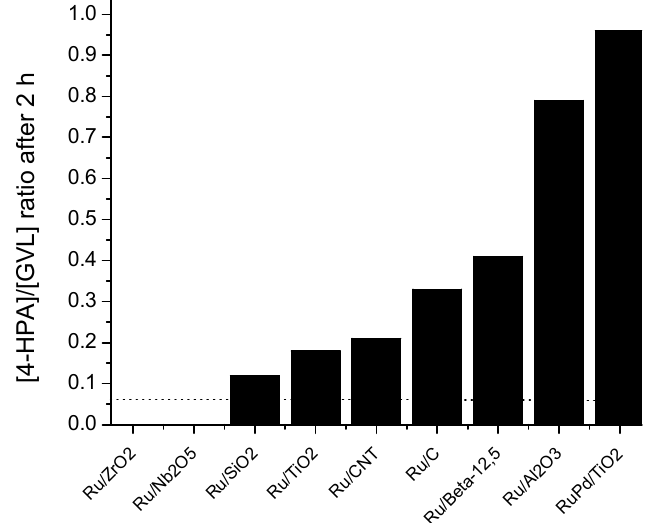
Figure 10. [4-HPA]/[GVL] ratio after 2 h batch time for various supported Ru catalysts. Dotted line-equilibrium value. Reaction conditions: 90 ◦ C, 45 bar H 2 , C LA,0 = 0.6–0.7 mol/L, m cat = 0.06 g, stirring rate = 2000 rpm.